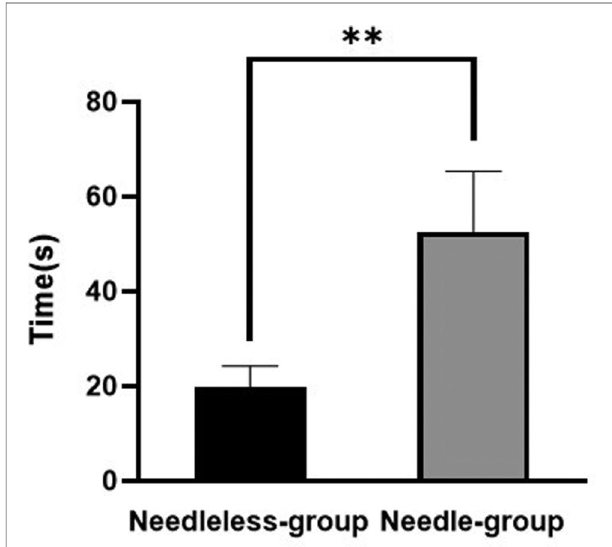
FIGURE 4 | The mean graft preparation time in the needle stitching technique group (needle group) and the needleless grasping suture technique group (needleless group). ** p <0.05.